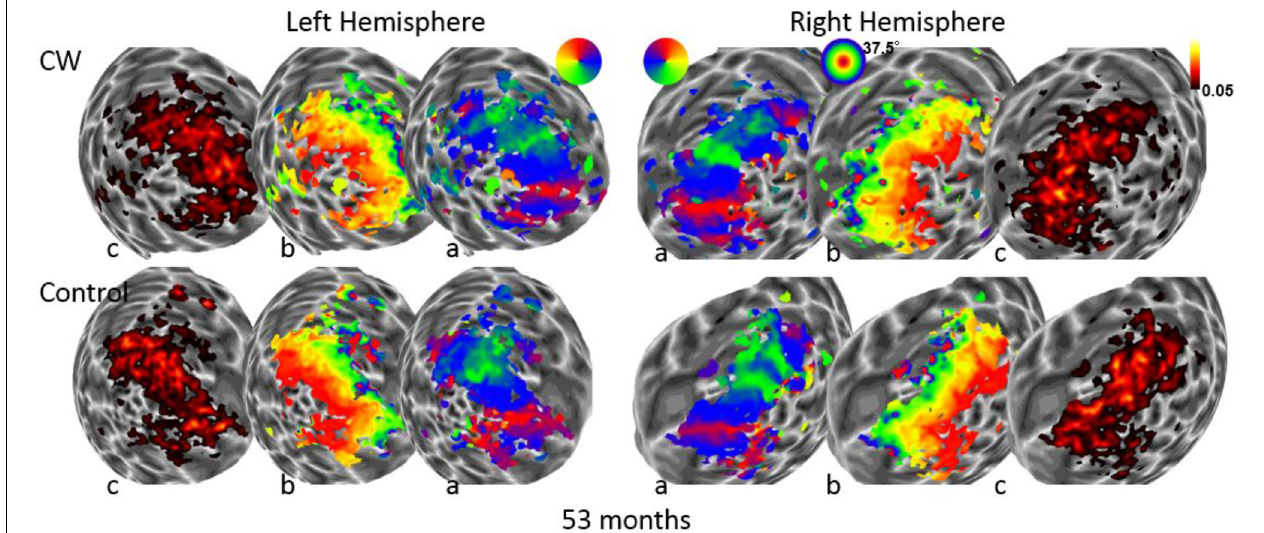
FIGURE 2 | Maps for polar angle (a) , eccentricity (b) , and R2 of model fits (c) on a spherical model of the gray-white matter boundary of the occipital lobe. Maps for CW and one of the control participants are shown from the first retinotopic mapping session at 53 months using a wide field stimulus (37.5 ◦ maximal eccentricity). All maps are thresholded at